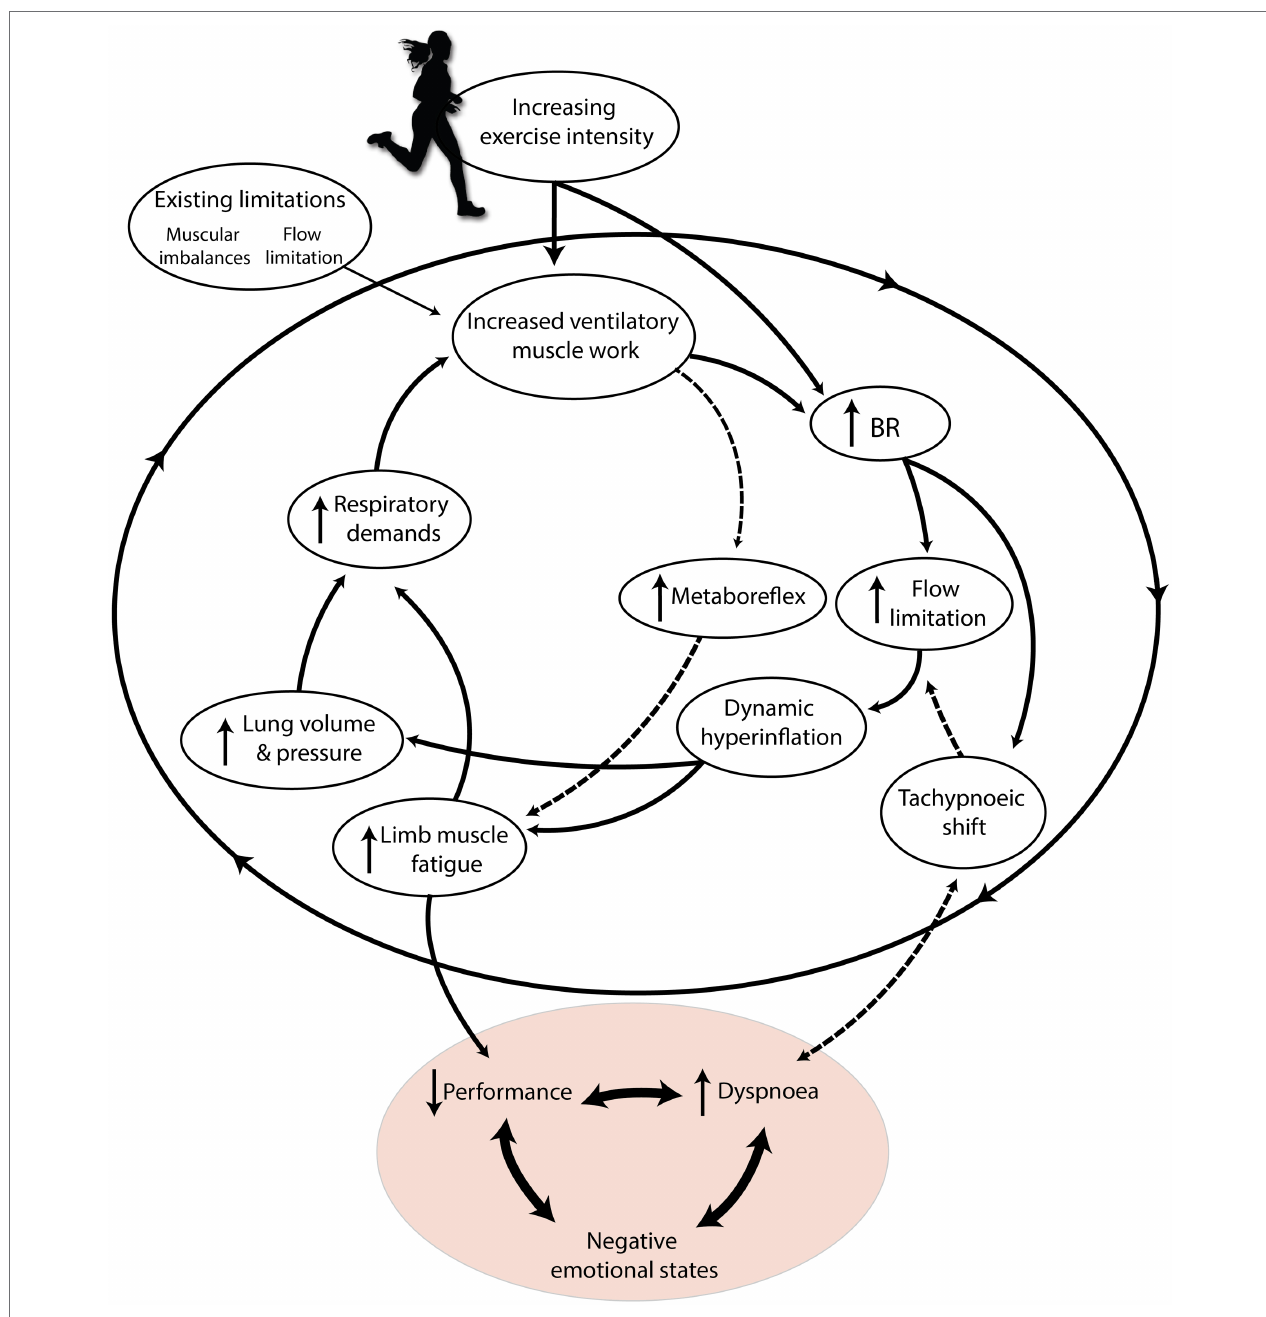
FIGURE 2 | The “respiratory limiting cycle” cascade of phenomena leading to respiration limiting exercise performance and enjoyment. Increasing exercise intensity interacts with pre-existing individual constraints, causing an accumulation of respiratory phenomena that ultimately harm performance and cause dyspnoea. Dashed arrows indicate mechanisms specific to high relative exercise intensities. Adapted with permission from BradCliff® and Bradley and Clifton-Smith